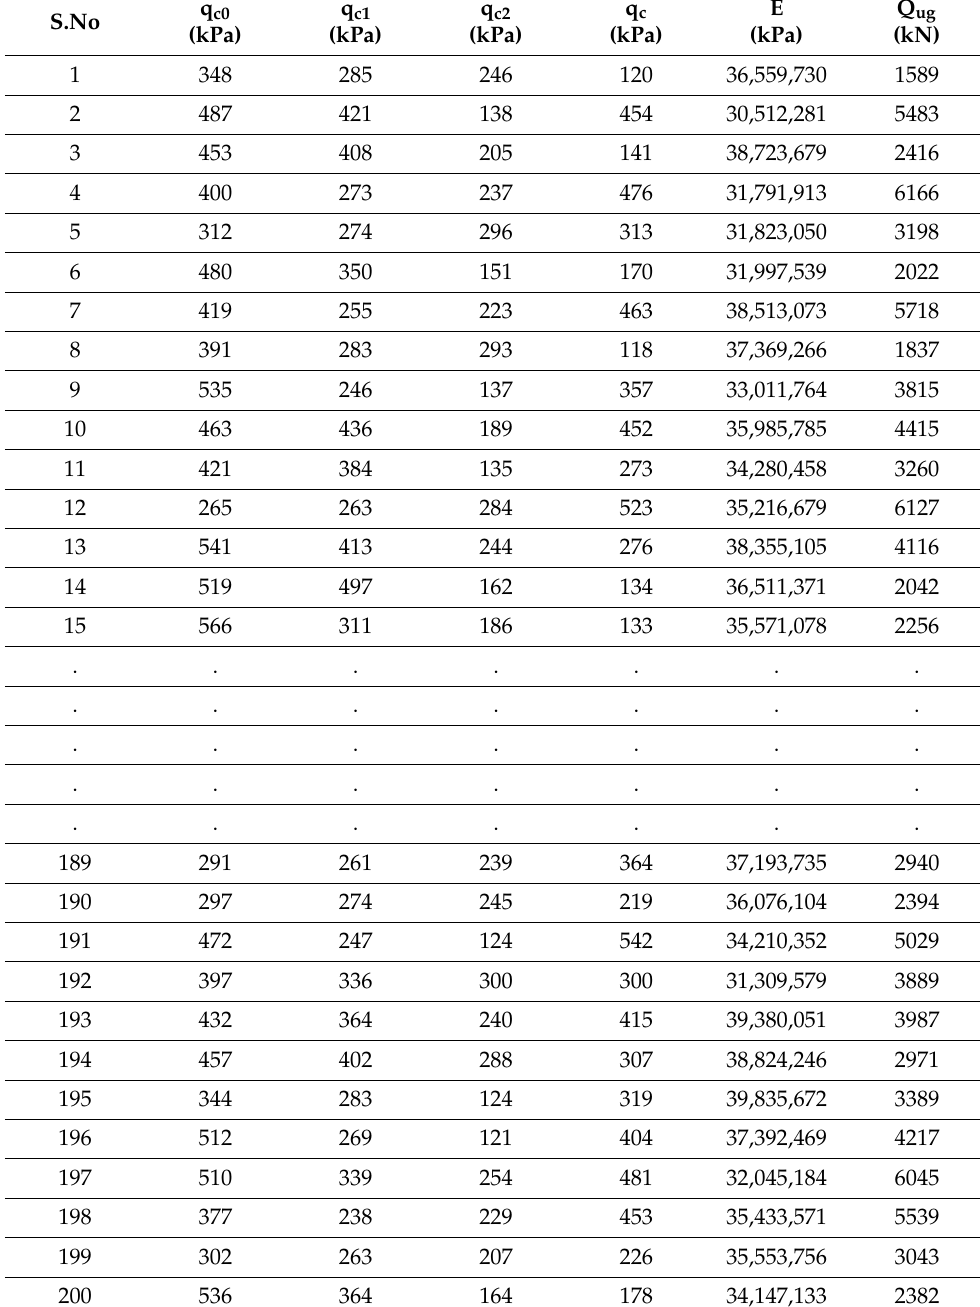
Table 5. Estimated pile group capacity ( kN ) for the entire length of the pile at the Perniö test site in